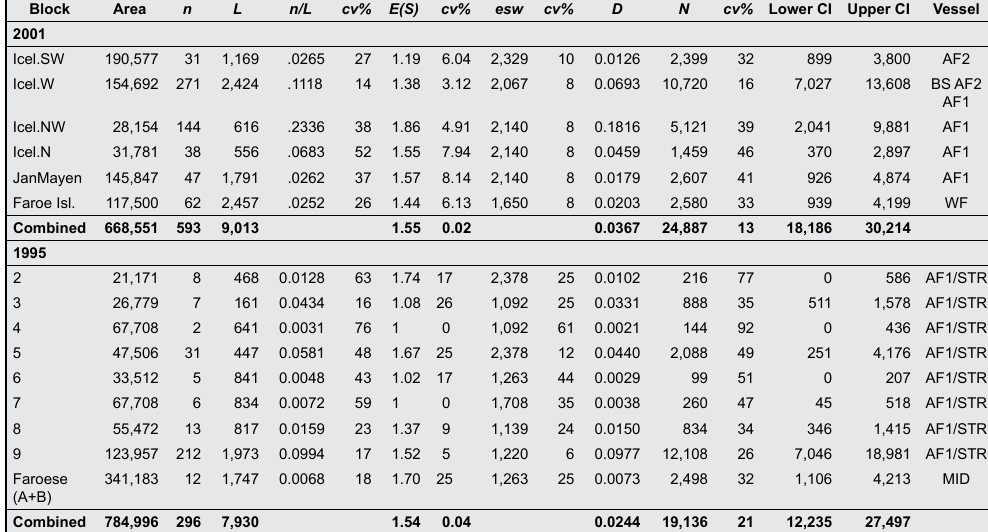
Table 4. Estimated density and abundance of fin whales from NASS-95 and NASS-2001, using a covariate model to estimate the detection function and incorporating stratum level estimates of effective search width ( esw in m ). n -number of sightings; D density of animals; E(S) group size; N -total abundance by blocks. Track length ( L ) in nautical miles and area in square nauti- cal miles. For vessel identity see Table 2. Block